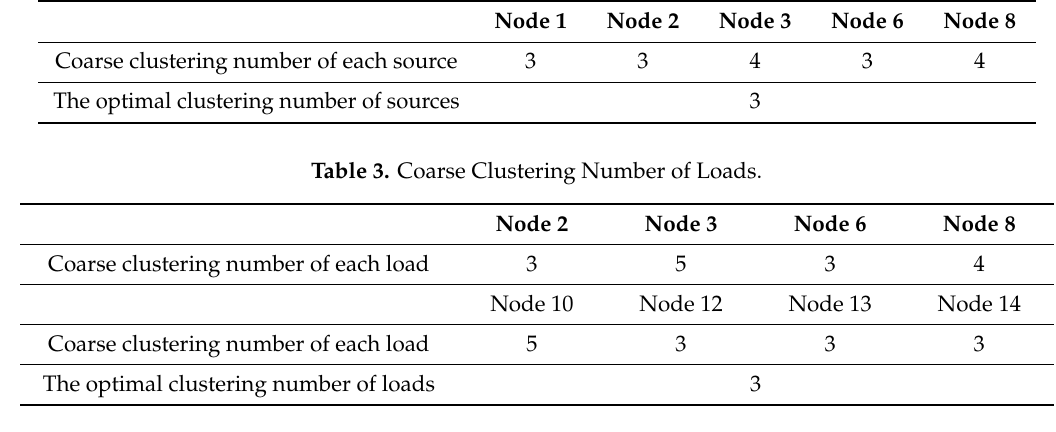
Table 2. Coarse Clustering Number of Renewable Sources.